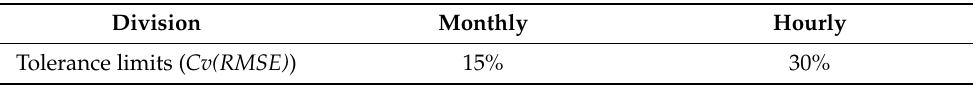
Table 10. ASHRAE guideline of tolerance limits for the Cv ( RMSE ) of building energy